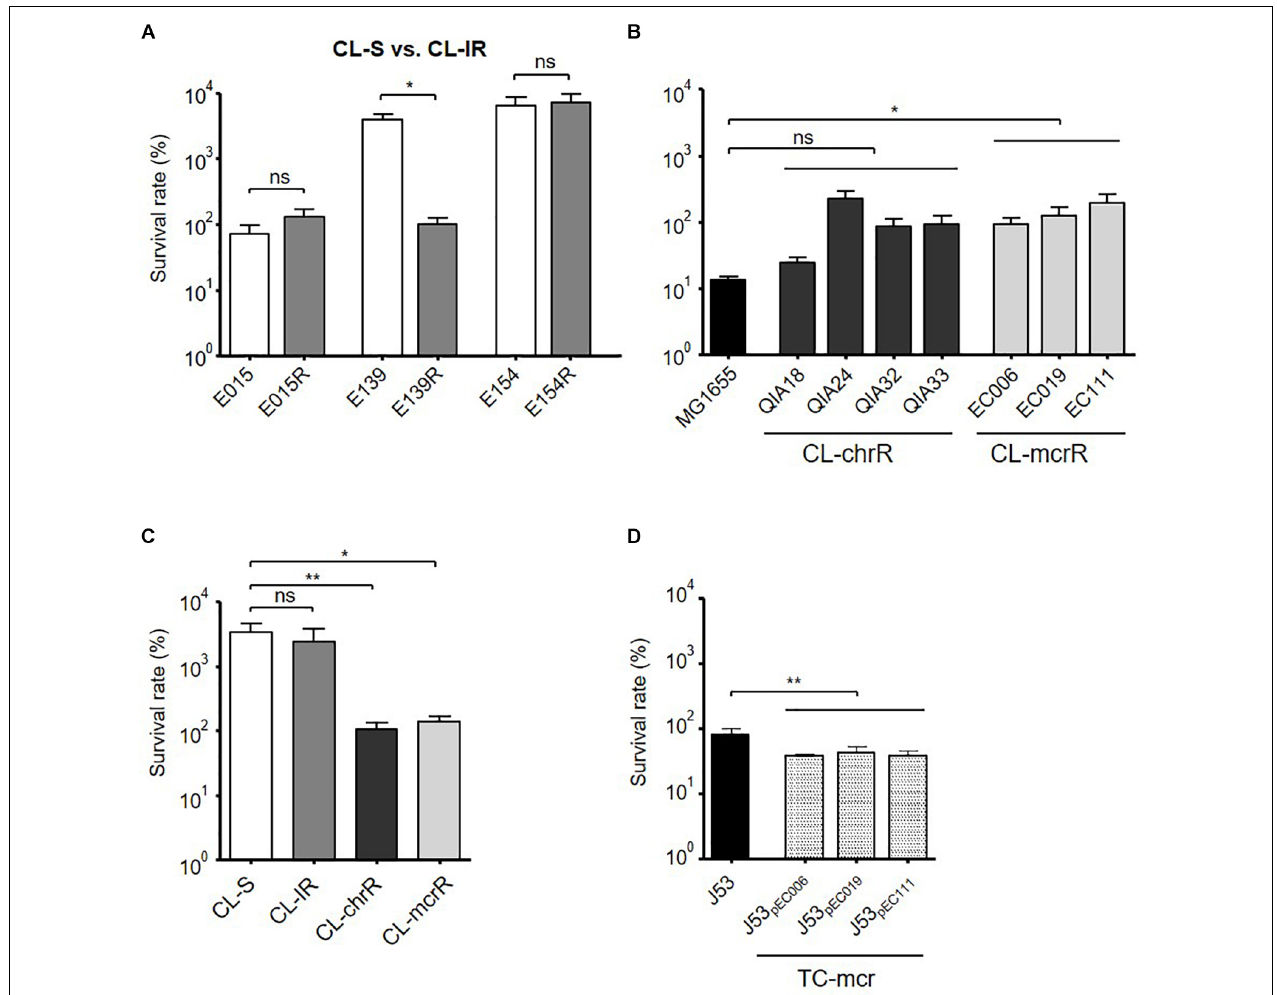
FIGURE 6 | Bacterial survival rates in macrophages. Survival rates of bacterial strains inside macrophages (J774A.1), which were measured at 4 h of infection. (A) Comparison of survival rates in macrophages between CL-S and CL-IR strains. (B) Survival rates of CL-chrR and CL-mcrR strains in macrophages were compared with that of E. coli reference strain MG1655. (C) Comparison of survival rates in macrophages among CL-S, CL-IR, CL-chrR, and CL-mcrR strains. (D) Survival rates of TC-mcr strains in macrophages were compared with that of their recipient strain, J53. The error bars indicate the standard deviations. Statistics were conducted with unpaired, two-tailed t -test. * P ≤ 0.05; ** P ≤ 0.01; ns, not